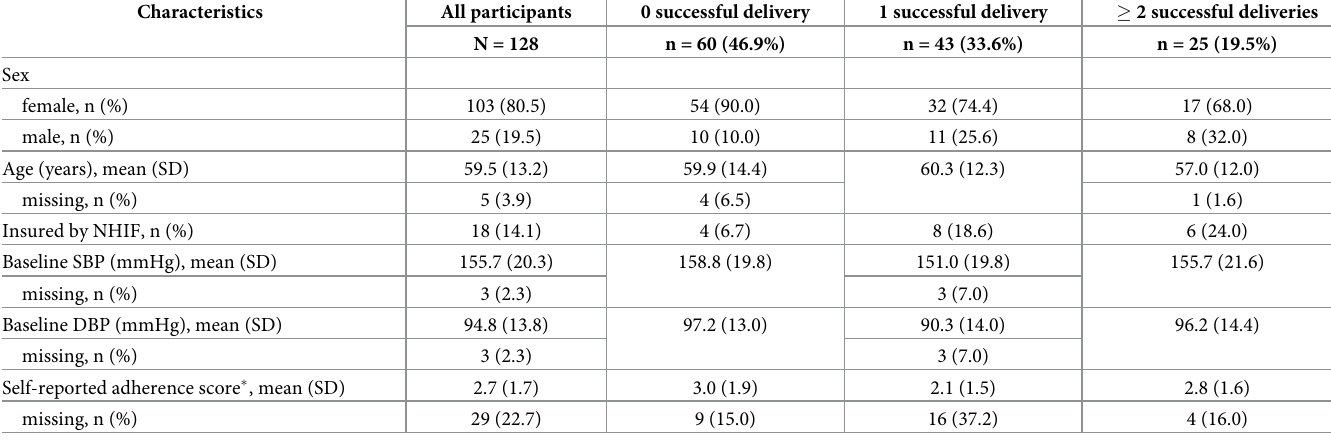
Table 1. Baseline characteristics of all participants (N = 128), stratified by number of delivery attempts. Characteristics